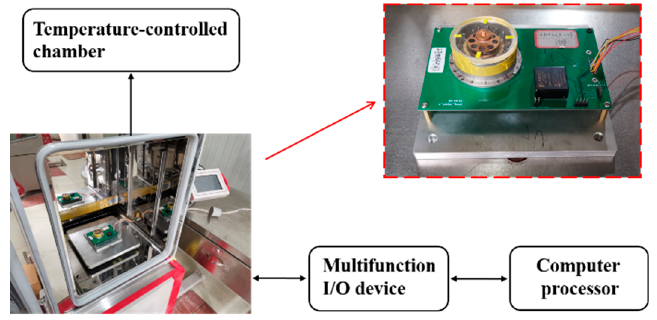
Figure 2. The diagram of the experimental setup used for the testing.